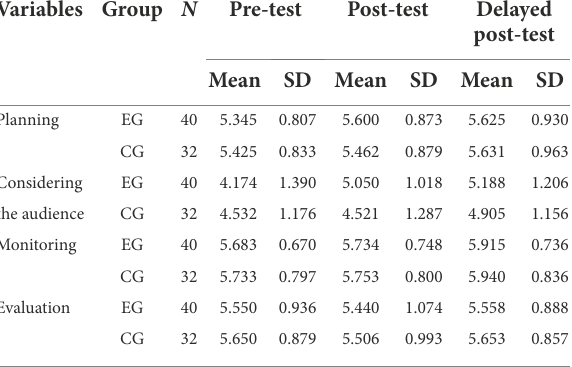
TABLE 2 Descriptive statistics for metacognitive strategies